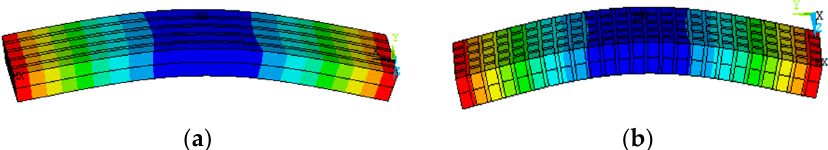
Figure 6. Displacement deformation graph of the 2 ‐ 2 and 1 ‐ 3 piezoelectric composite bilaminated vibrators. ( a ) 2 ‐ 2. ( b ) 1 ‐ 3.